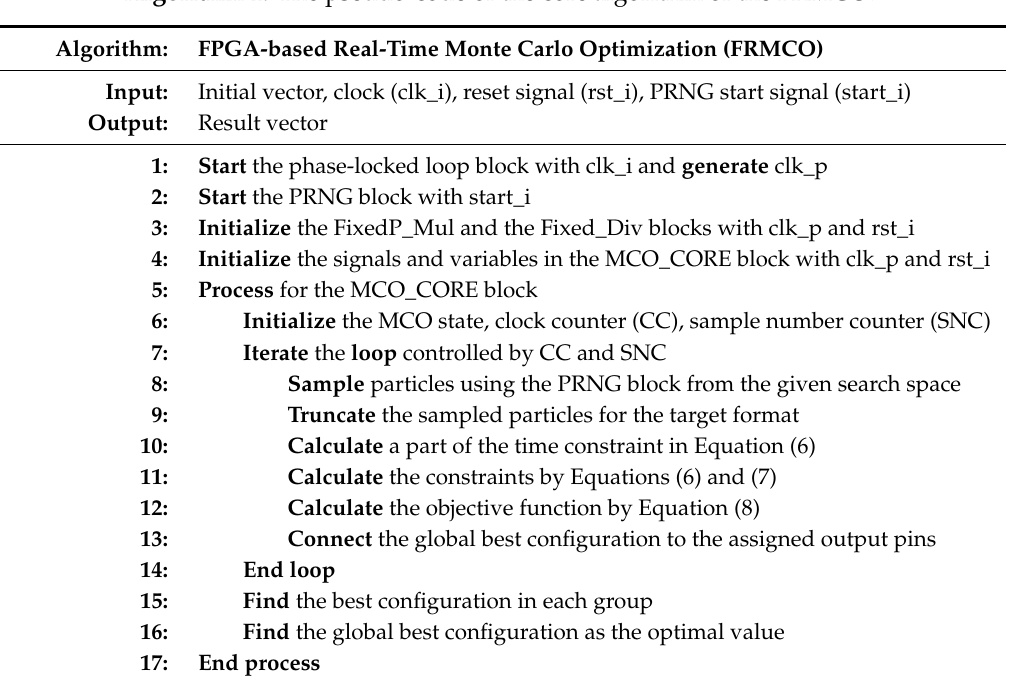
Algorithm 1. The pseudo-code of the core algorithm of the FRMCO.